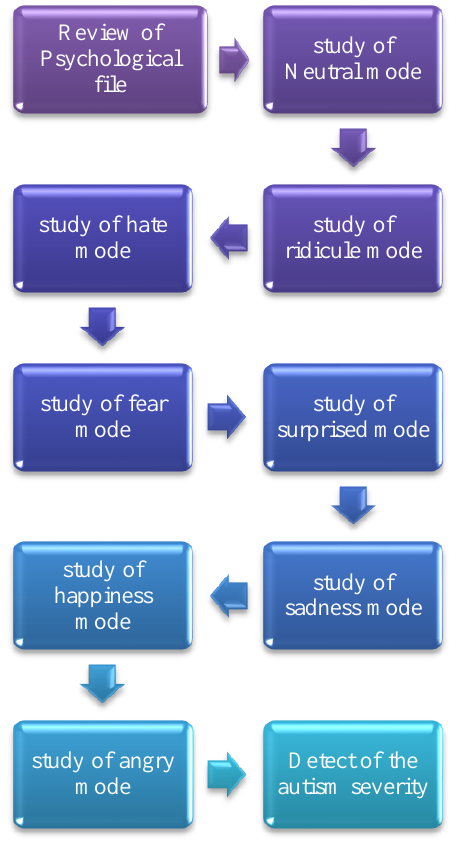
Figure 1. Implementation Model